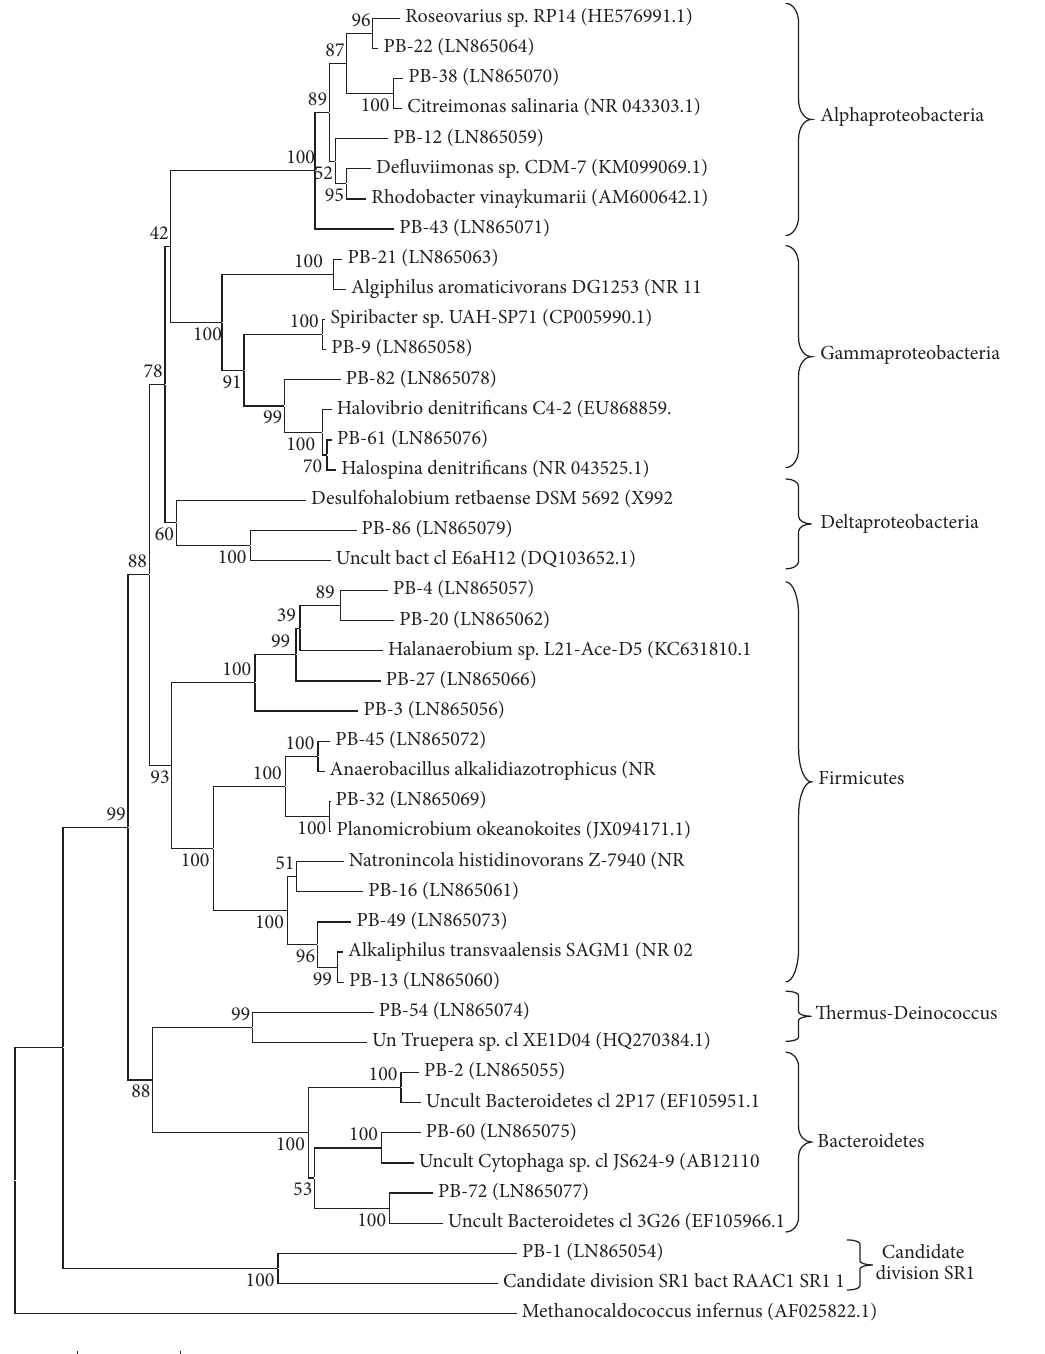
Figure 3: Neighbor-joining phylogenetic tree based on archaeal 16S rDNA sequences found in a crystallizer pond, PS. Bar, 5% substitutions in nucleotide sequence. Bootstrap values greater than 70% confidences are shown at branching points (percentage of 1000 resamplings). Sequenceaccessionnumbersaregiveninparenthesis.Asequencefromthethermoacidophilicarchaeon Sulfolobusacidocaldarius thatbelongs to the phylum Crenarchaeota constituted the out